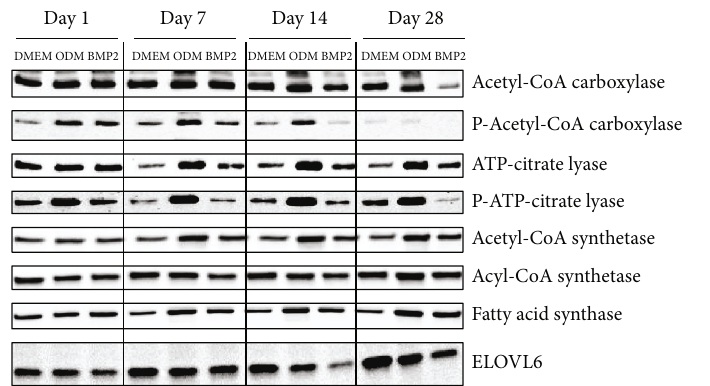
Figure 3: Expression of lipid metabolism markers during osteogenic di ff erentiation of DFCs. DFCs were cultured in osteogenic di ff erentiation medium (ODM), BMP2 di ff erentiation medium, or control medium (DMEM) for one, seven, 14, and 28 days before protein expression of acetyl-CoA carboxylase, phospho-acetyl-CoA carboxylase, ATP-citrate lyase, phospho-ATP-citrate lyase, acetyl-CoA synthetase, acyl-CoA synthetase, fatty acid synthase, and elongation of very long chain fatty acids protein 6 (ELOVL6) was determined by western blot analysis. Quanti fi cation results and statistical analysis are shown in the Supplementary Table